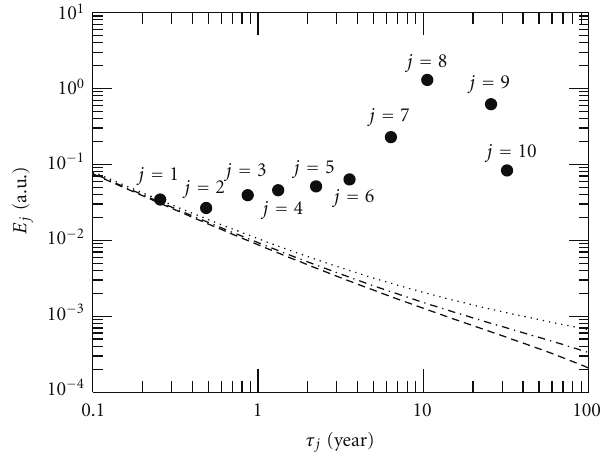
Figure 3: Average amplitude ( E j ) versus typical period ( τ j ) of the j IMFs ( j values from 1 to 10) identified in the CLI data through the EMD. Dashed, dot-dashed, and dotted lines indicate the 90th, 95th, and 99th percentile,